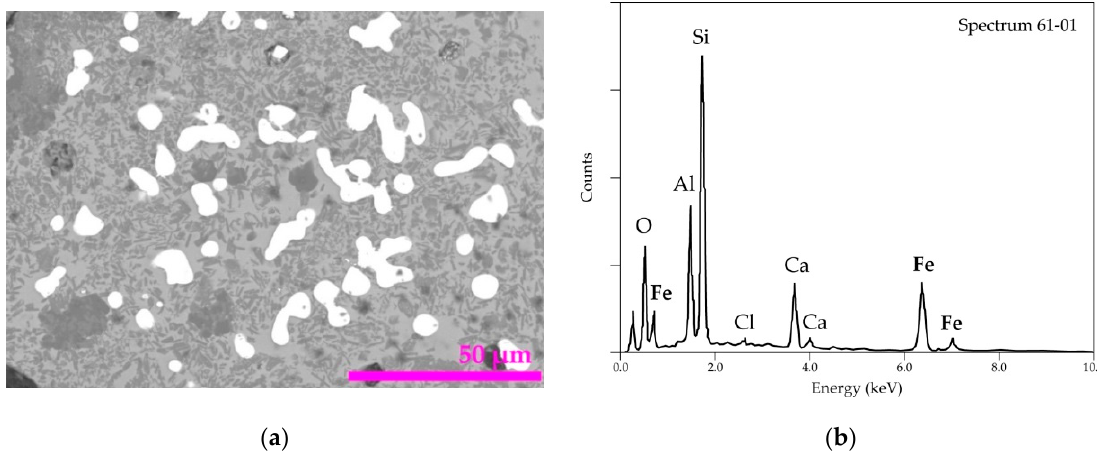
Figure 13. SEM-EDS results of the residue obtained from the treatment of the pellets at 1025 °C for 1 h: ( a ) general view of the obtained residue and ( b ) overall EDS analysis of the residue sample.